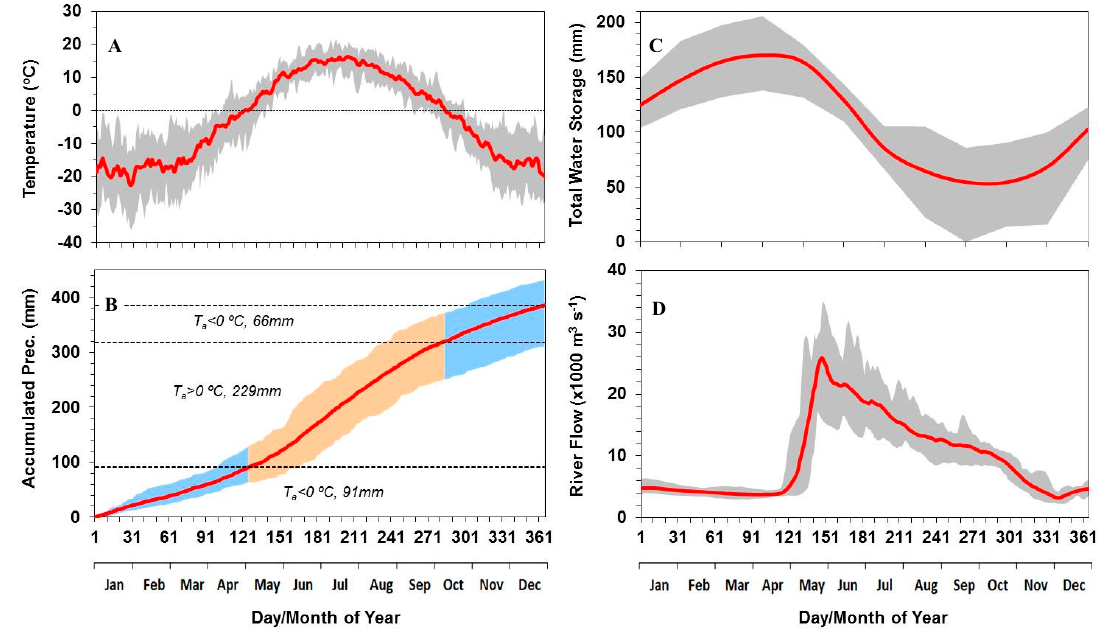
Figure 4. Hydroclimate characterization for the Mackenzie River Basin during the study period of 2003–2014. ( A ) Daily air temperature; ( B ) Accumulated precipitation during a year (blue represents snow; orange represents rain); ( C ) Total water storage change from the Gravity Recovery and Climate Experiment (GRACE) satellite observations; and ( D ) Daily river flow measured at the hydrometric station. More details on the data sources can be found in Section 3.2. Red lines in all panels represent the mean values over the study period of 2003–2014. Shadowed areas represent the maximum and minimum variation ranges within the study years.